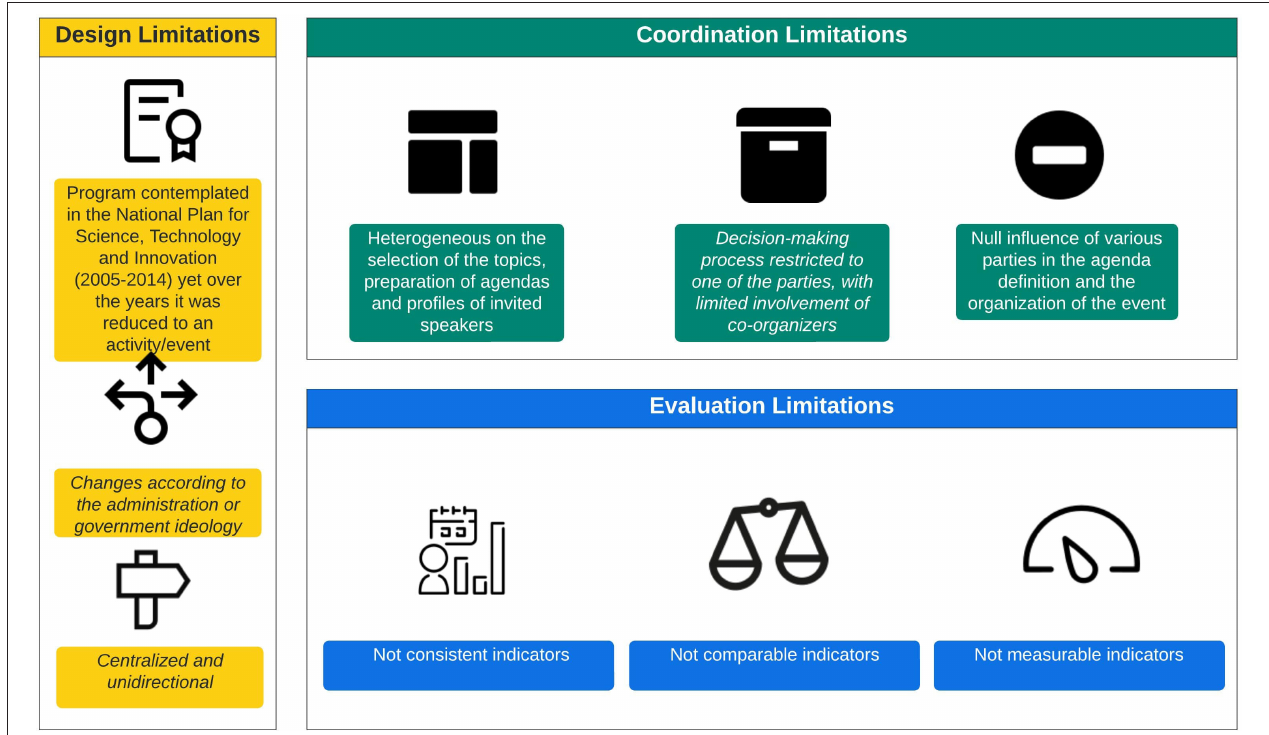
FIGURE 3 | Limitations of Converciencia as a science and technology practice. Source: own